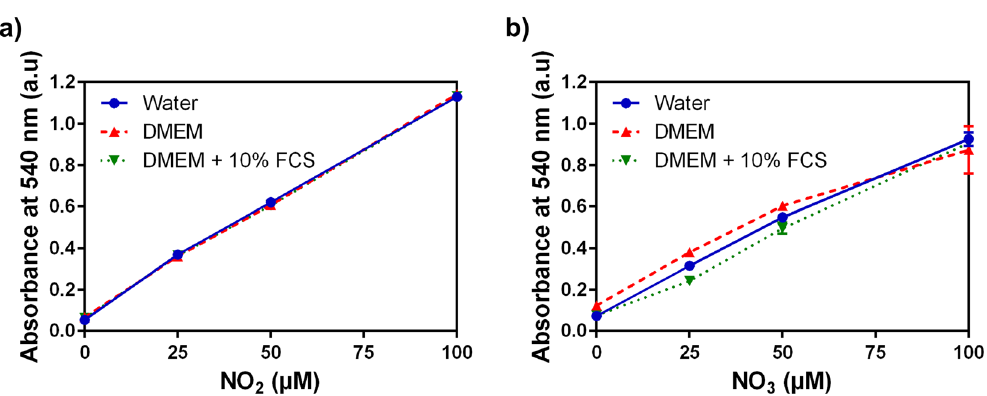
Figure 15. Calibration curves of ( a ) Nitrite anion and ( b ) Nitrate anion concentration in three